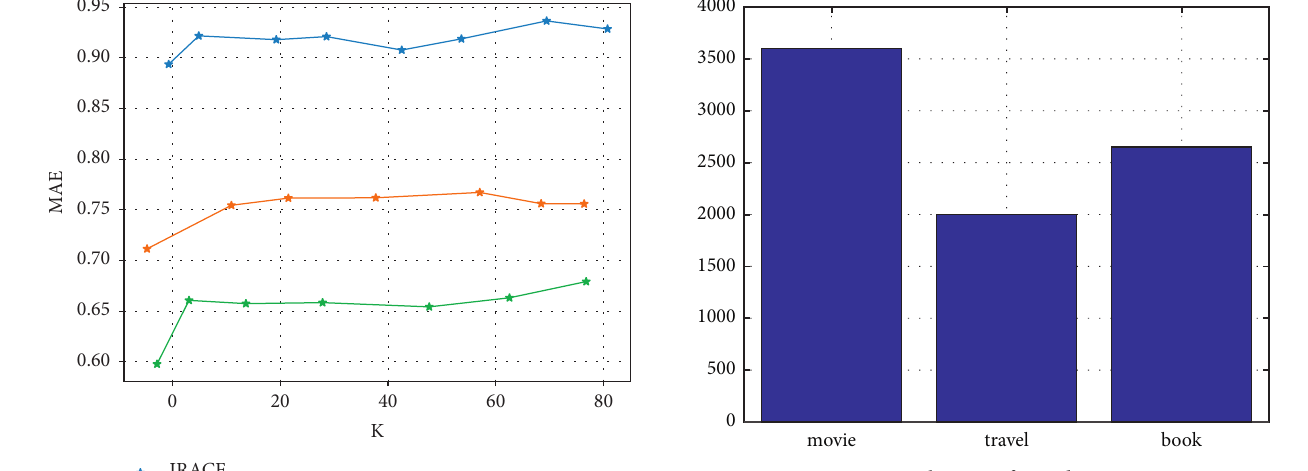
Figure 8: Distribution of test data